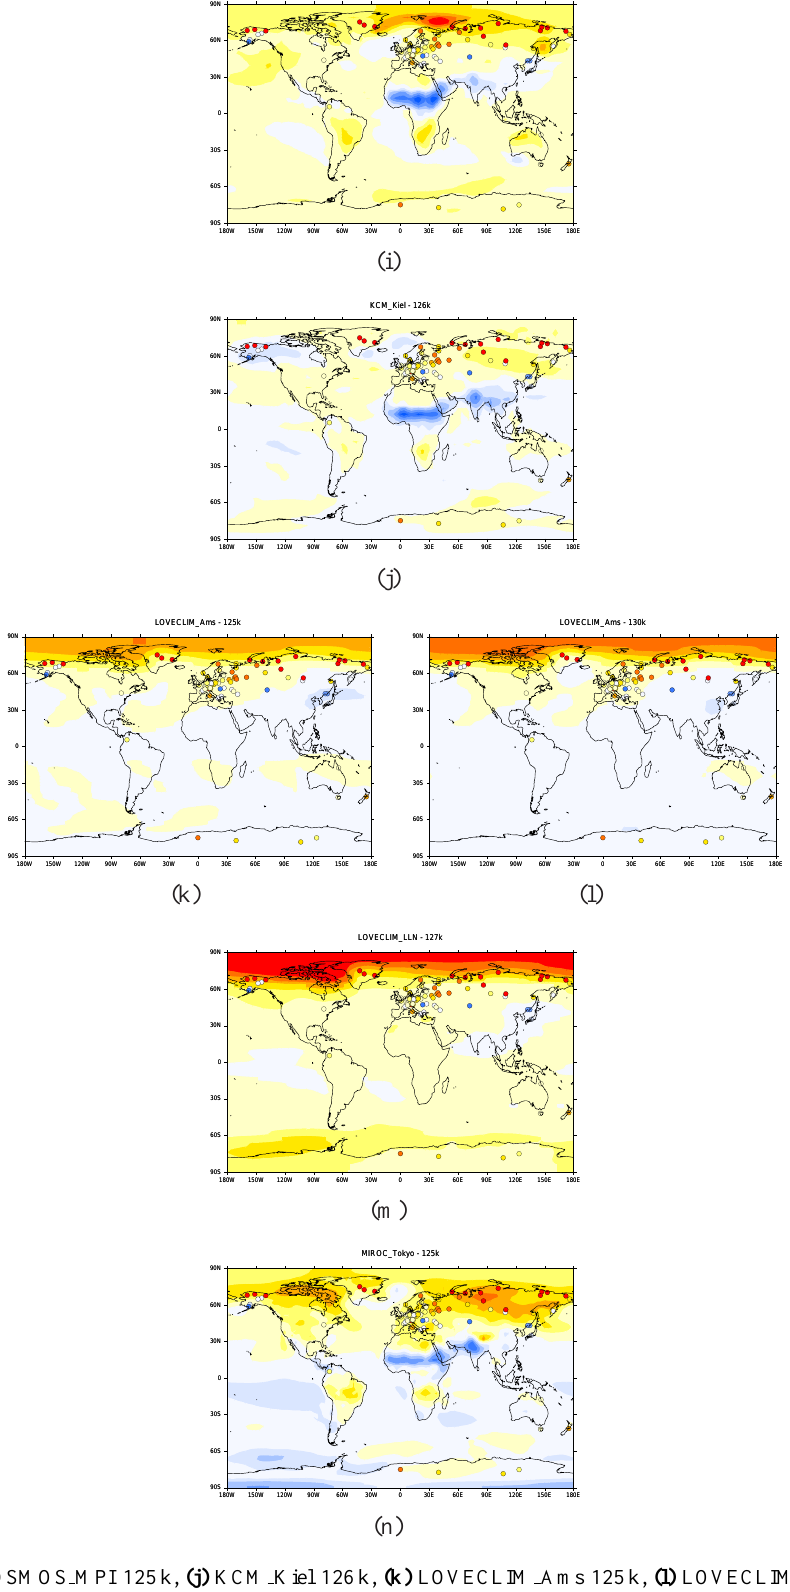
Fig. 5. Continued. (i) COSMOS MPI 125k, (j) KCM Kiel 126k, (k) LOVECLIM Ams 125k, (l) LOVECLIM Ams 130k, (m) LOVE- CLIM LLN 127k, (n) MIROC Tokyo